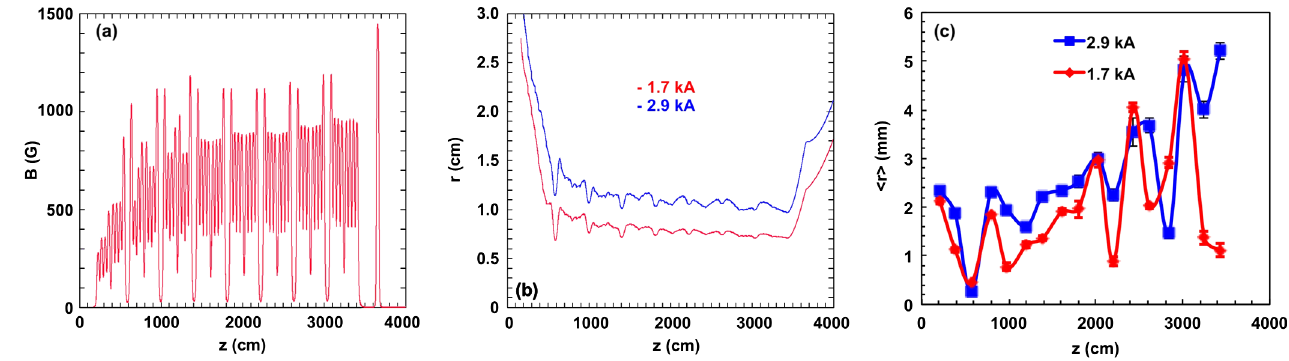
FIG. 2. (a) Solenoid lattice for tune used to transport the 1.7 kA beam, (b) calculated envelope comparison between the nominal 1.7 kA beam (red) and the 2.9 kA beam (blue), and (c) measured rms beam centroid offsets, h r i , for both current